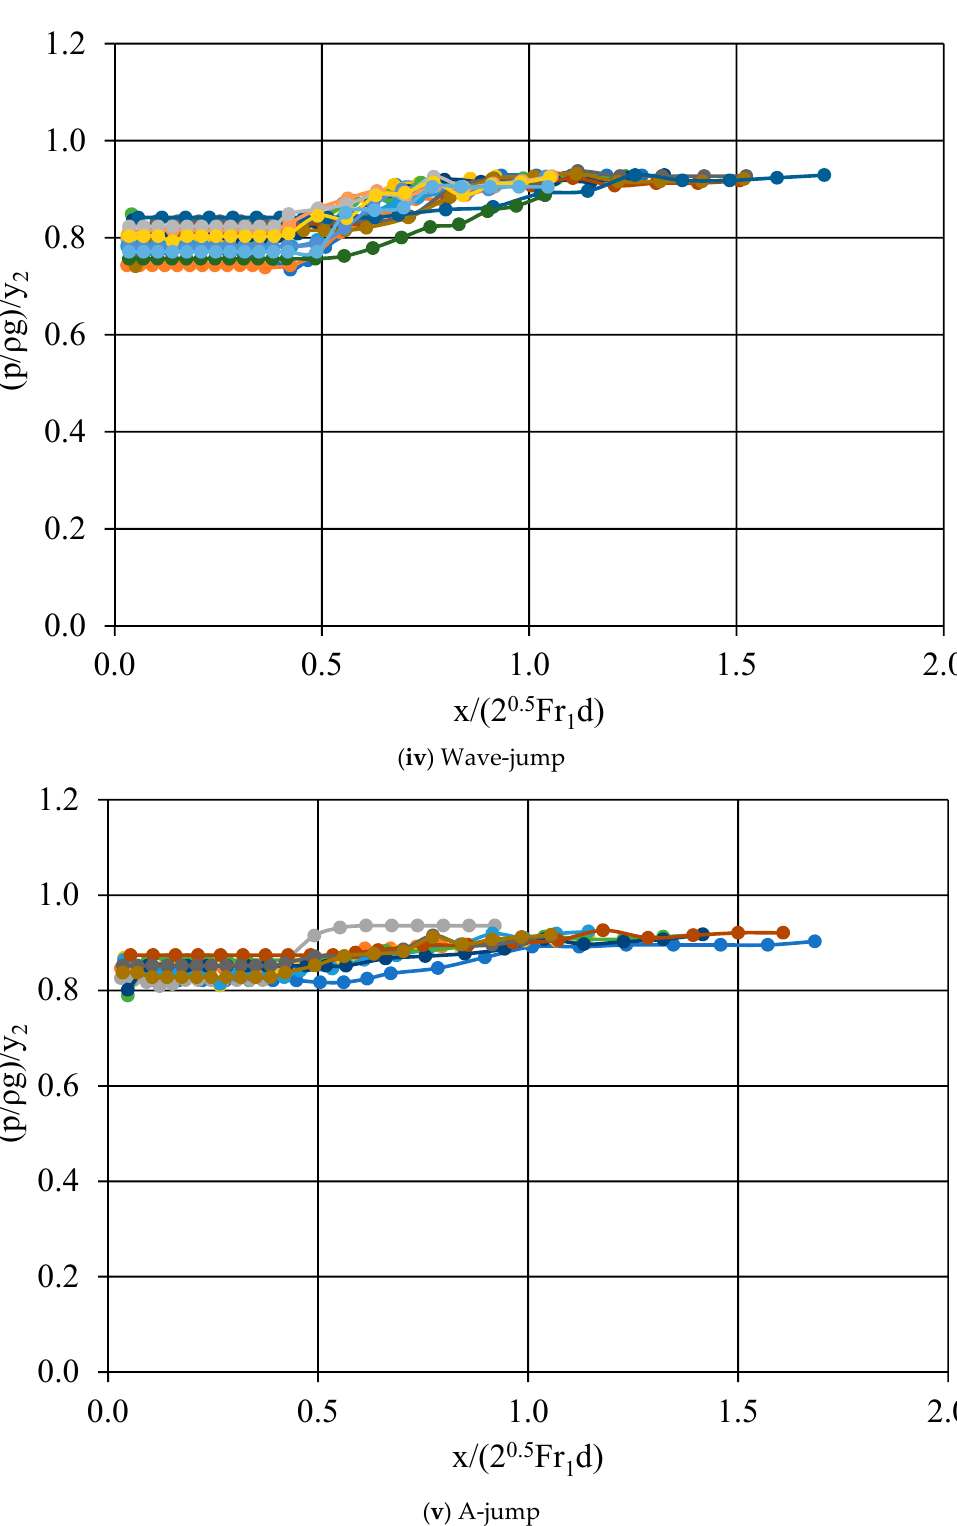
Figure 10. Distribution of dimensionless measured pressure head along the bottom of the channel versus the dimensionless horizontal distance downstream of the drop ( i ) min B-jump, ( ii ) B-jump, ( iii ) wave-train, ( iv ) wave-jump, and ( v ) A-jump.